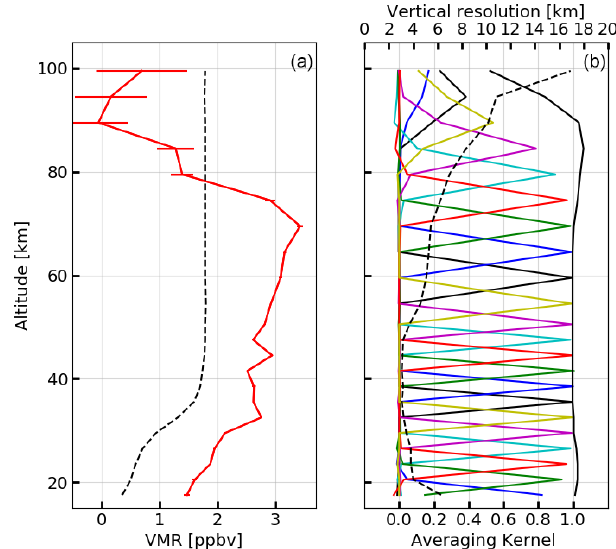
Figure 3. (a) An example of a HCl profile retrieved from the H 35 Cl spectrum on 15 November 2009 at a latitude of 38.3 ◦ N, longitude of 12.7 ◦ E, and SZA of 160.9 ◦ . The solid red line indicates the re- trieved HCl volume mixing ratio (VMR), and the error bar is the root sum square of the smoothing and measurement errors. The dashed black line is an a priori HCl profile used for the retrieval procedure. Panel (b) shows the averaging kernel, the measurement response (indicated by the thick black line), and the FWHM of the averaging kernel profile (indicated by the thick dashed black